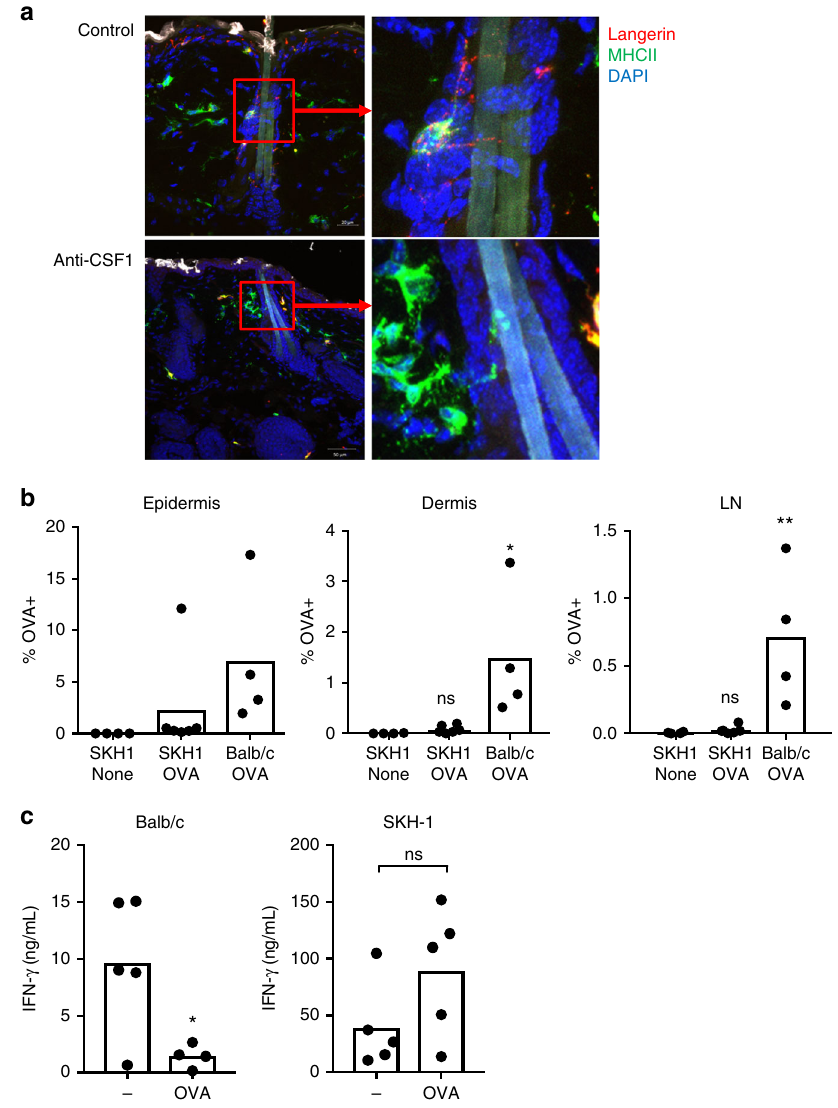
Fig. 8 Dermal DCs acquire topical antigen through hair follicles. a Confocal microscopy of skin 24 h after patch application in a wild-type Balb/c mouse and mouse treated with anti-CSF1R antibody to deplete Langerhans cells. Scale bars, 20 μ m in control and 50 μ m in anti-CSF1R. b Percentage of OVA + cells in CD11c + MHCII + cells in the epidermis, dermis and lymph nodes (LN) 24 h after applying OVA AF647 . N = 4 – 6 mice/group. * p < 0.05, ** p < 0.01, ns, non- signi fi cant, One-way Anova, Tukey ’ s multiple comparison test. c Immune tolerance induced by topical OVA in SKH-1 and Balb/c mice ( N = 4 – 5/group). * p < 0.05, ns, non-signi fi cant, t